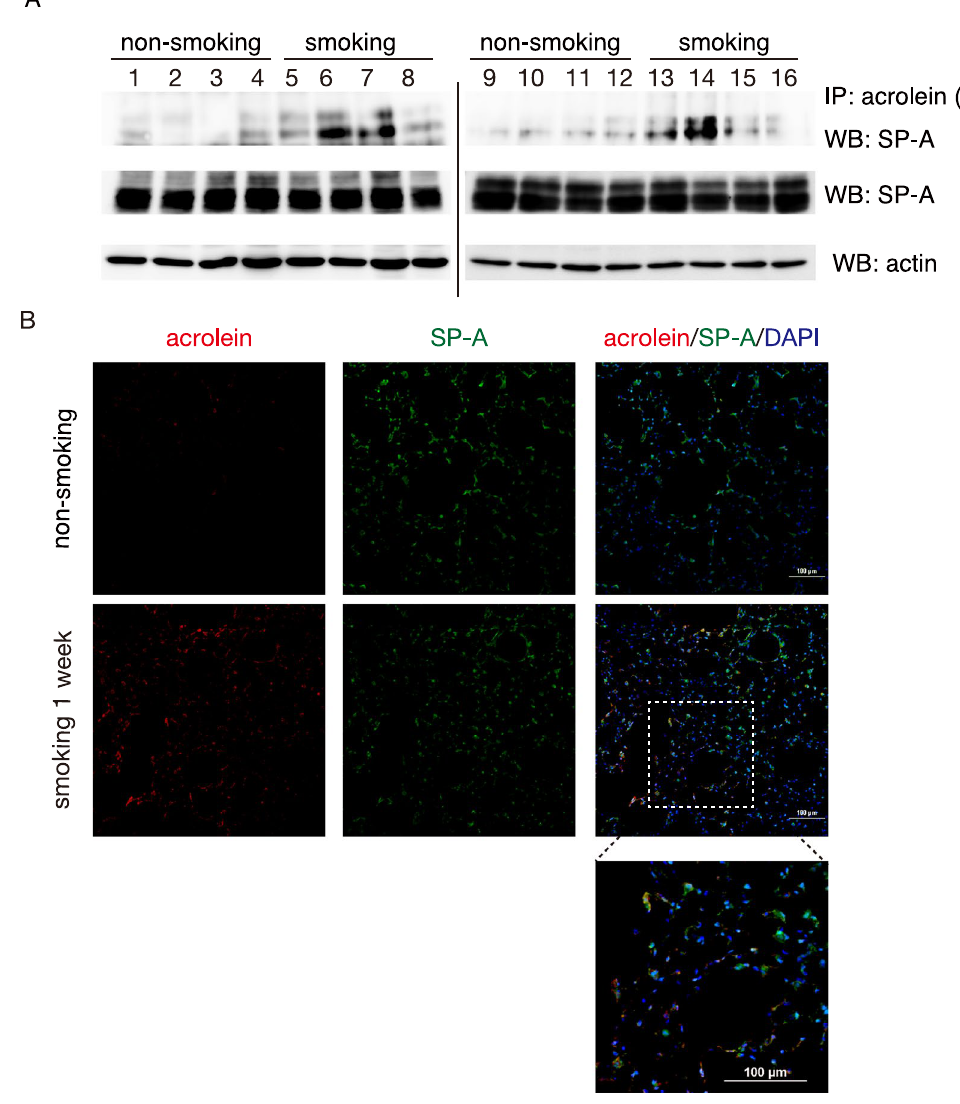
Figure 1. The expression of acrolein-modified SP-A in mouse lungs after 1 week of exposure to CS. Eight-week- old female C57BL/6 mice were exposed to the smoke from four unfiltered cigarettes per day for one week. ( A ) Upper panel: Lung tissue lysates were immunoprecipitated with anti-acrolein antibody (mAb5F6) and subjected to western blotting with anti-SP-A antibody. Lower panel: Lung tissue lysates were subjected to western blot analysis using anti-SP-A and anti-actin antibodies. Lanes 1–16 represent individual samples from n = 8 mice per group. Uncropped blots are shown in Supplementary Fig. S5. ( B ) Immunofluorescence staining of lung sections with anti-acrolein antibody (red), anti-SP-A antibody (green), and DAPI (blue). Scale bars: 100 μ m. These experiments were performed with n = 8 mice per group, and representative results are